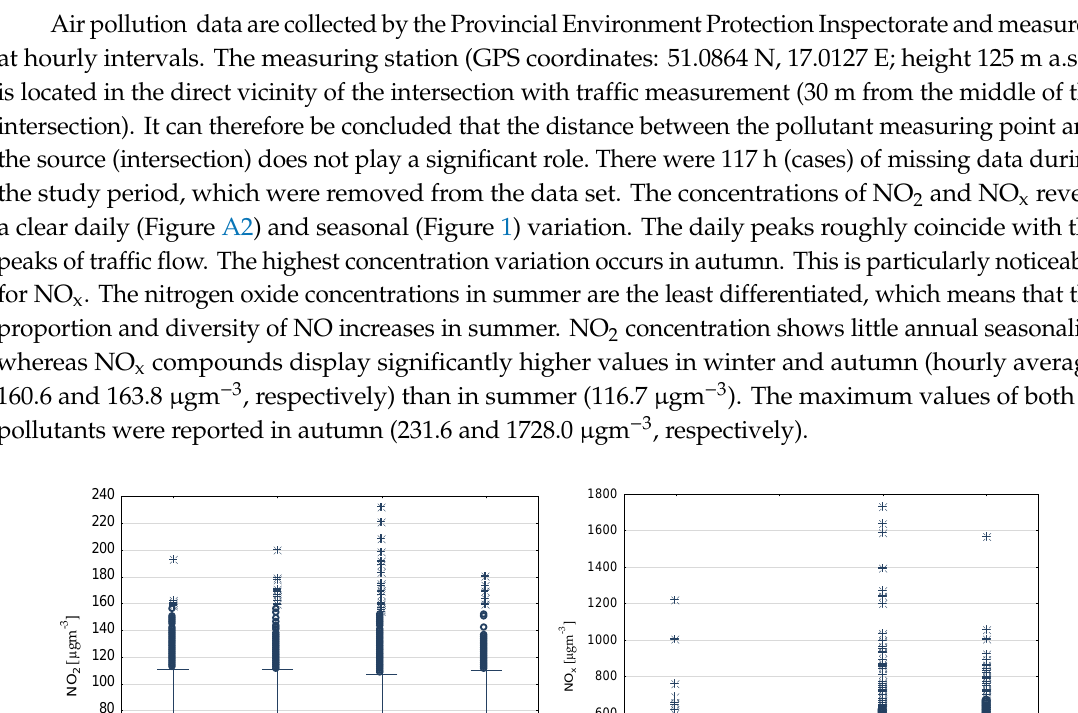
4 of 16 Table 1. Descriptive statistics for independent variables by season. Average